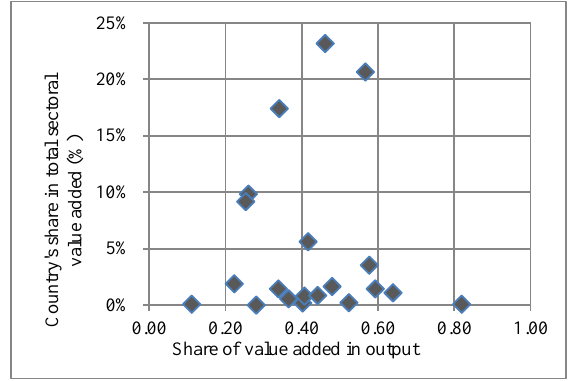
Fig. 1. Manufacture of basic pharmaceutical products and its preparations in the EU in 2010.